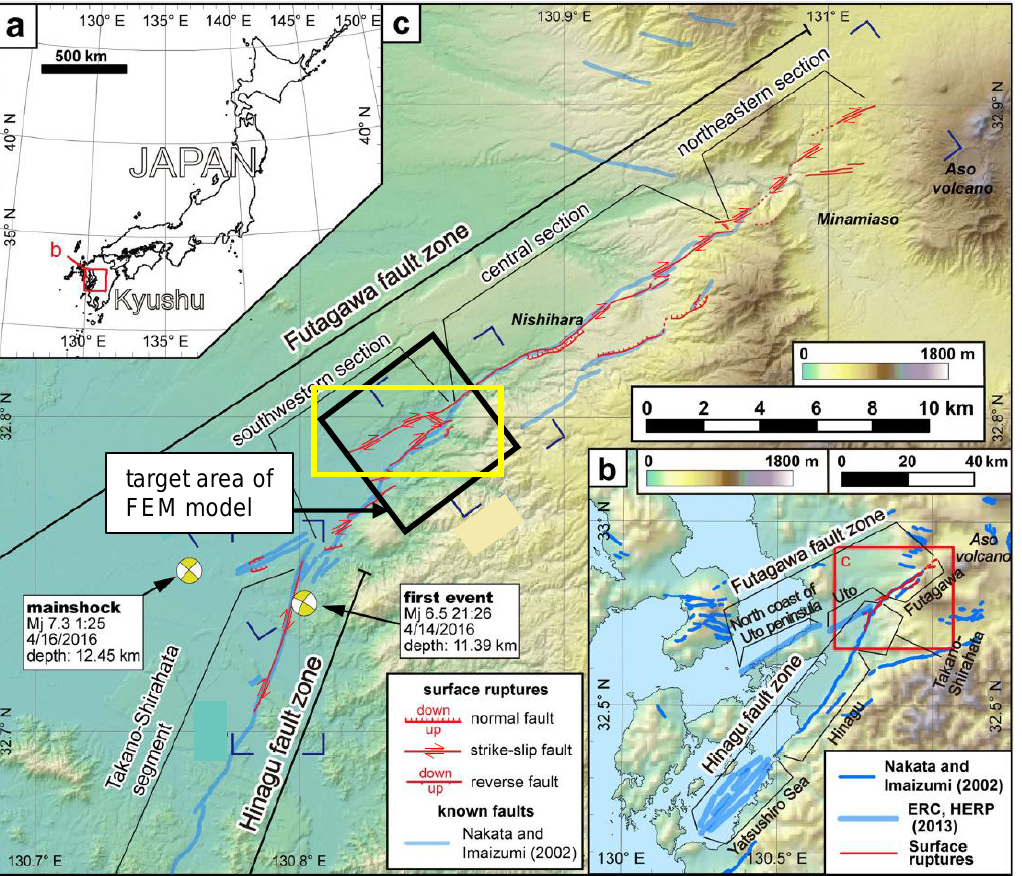
Figure 5. Map of the surface faults following the 2016 Kumamoto earthquake (modified, Shirahama et al. [20]). ( a ) Location of the study area in Kyushu, southwestern Japan. ( b ) Active faults in the western part of central Kyushu and the 2016 surface ruptures (red line). ( c ) Distribution of surface ruptures associated with the 2016 Kumamoto earthquake. The Yellow bordered box indicates the area of Figure 7. Blue corners indicate the areas studied in detail by Shirahama et al. [20].